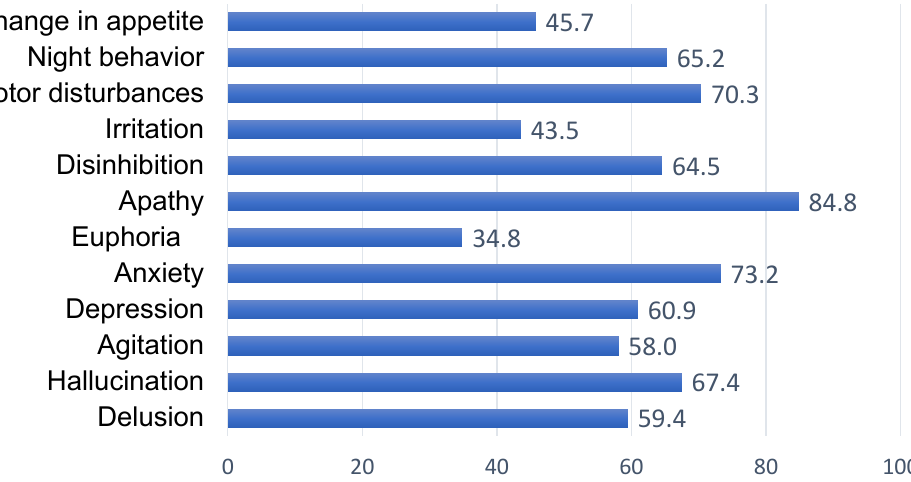
Figure 1. Graphical representation of care-recipients’ neuropsychiatric